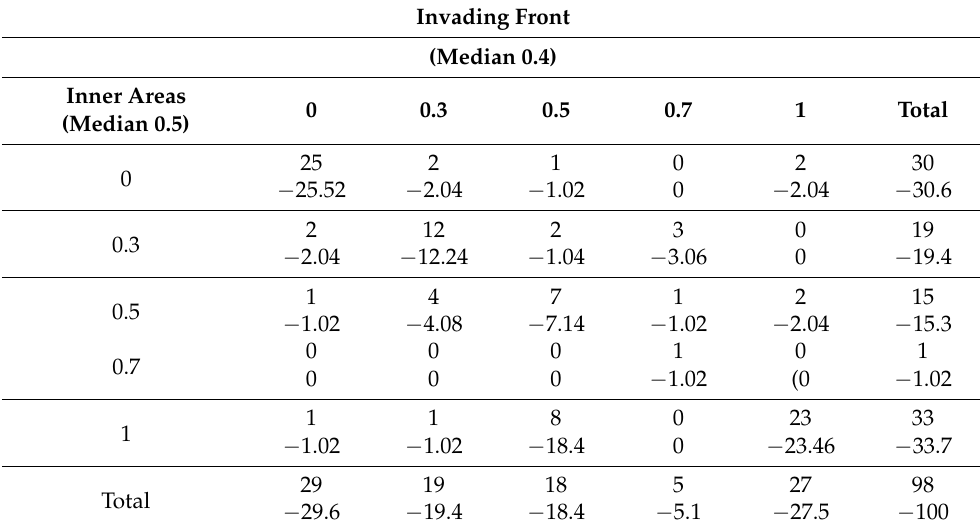
Table 2. Distribution of SIRP α /CD68-ratio among cases (invading front vs. inner tumor areas). Numbers in brackets aside numbers refer to the percentage of scored cases in the total of 98